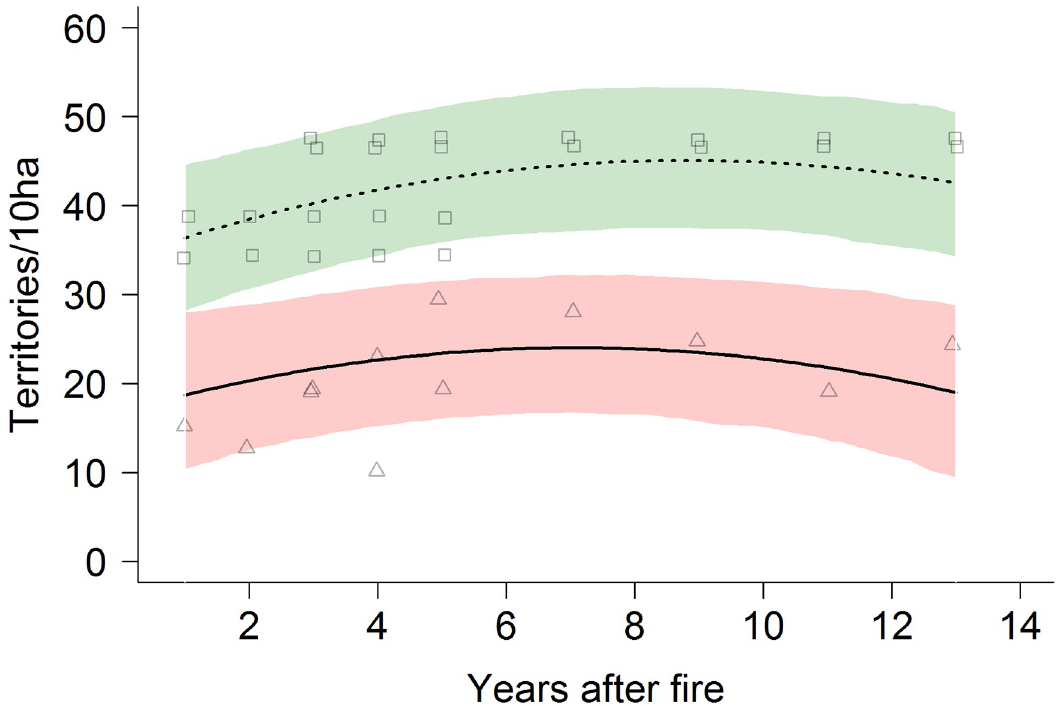
Fig 2. Average number of territories per 10 ha over all species in relation to years after fire. Shown are regression lines and 95% confidence intervals for the burnt forest (solid line, red) and control forest (dashed line,